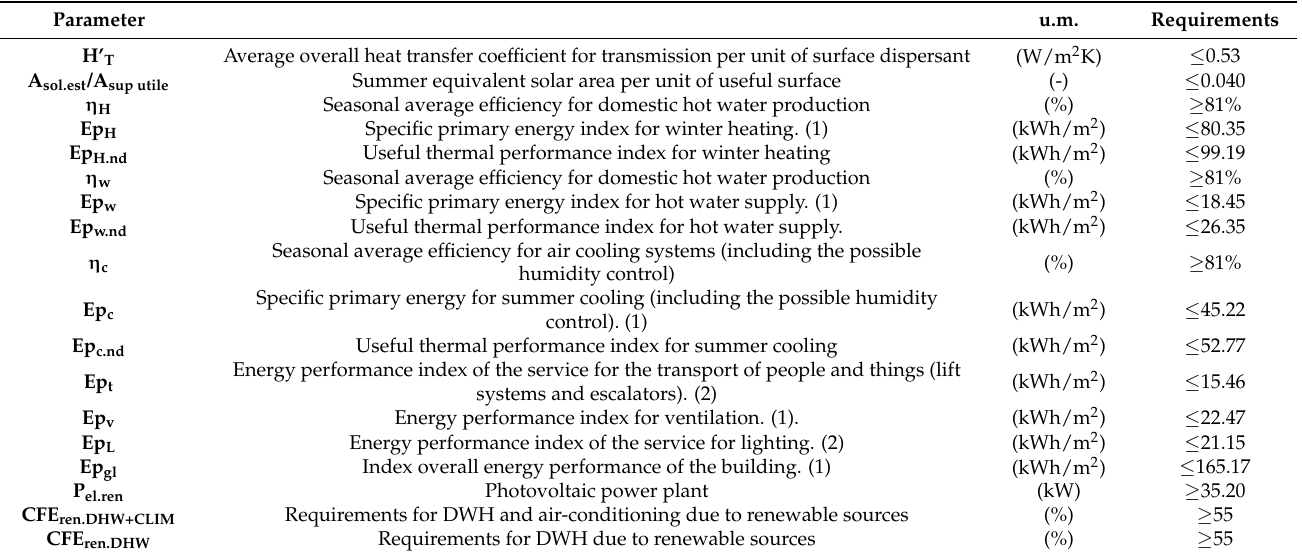
Table 6. Threshold limit